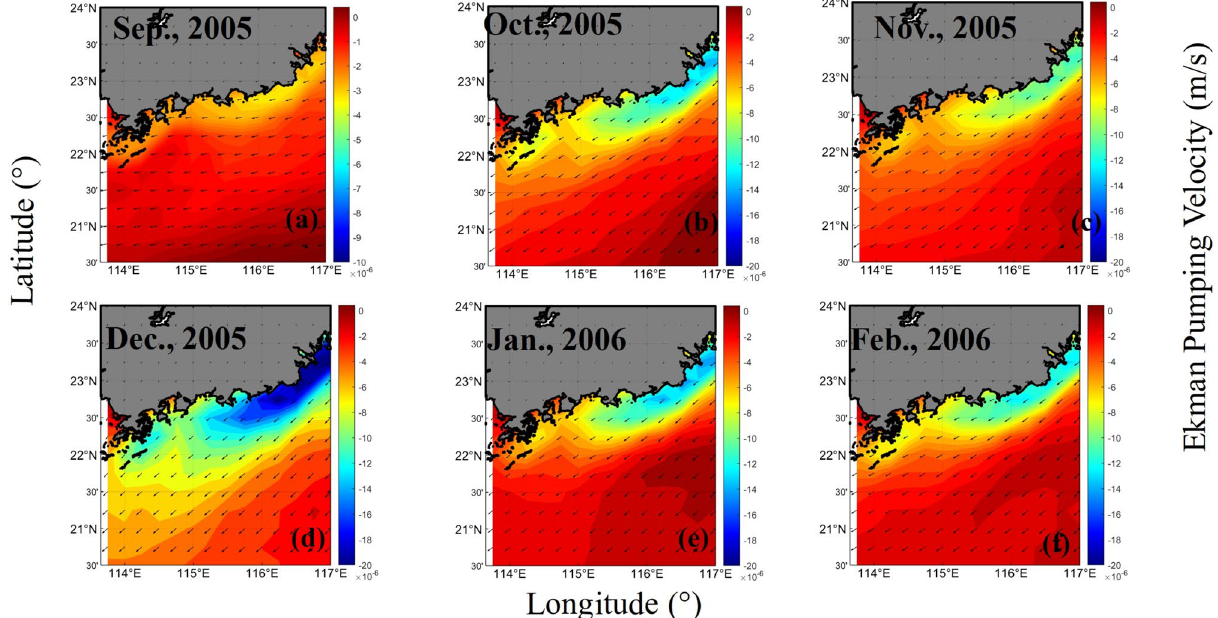
Figure 9. The monthly mean Ekman pumping velocities from September 2005 to February 2006 (a positive value denotes upwelling, and a negative value denotes downwelling). The program R (version 3.6.3, available at https:// www.r- proje ct. org) was applied for the map.